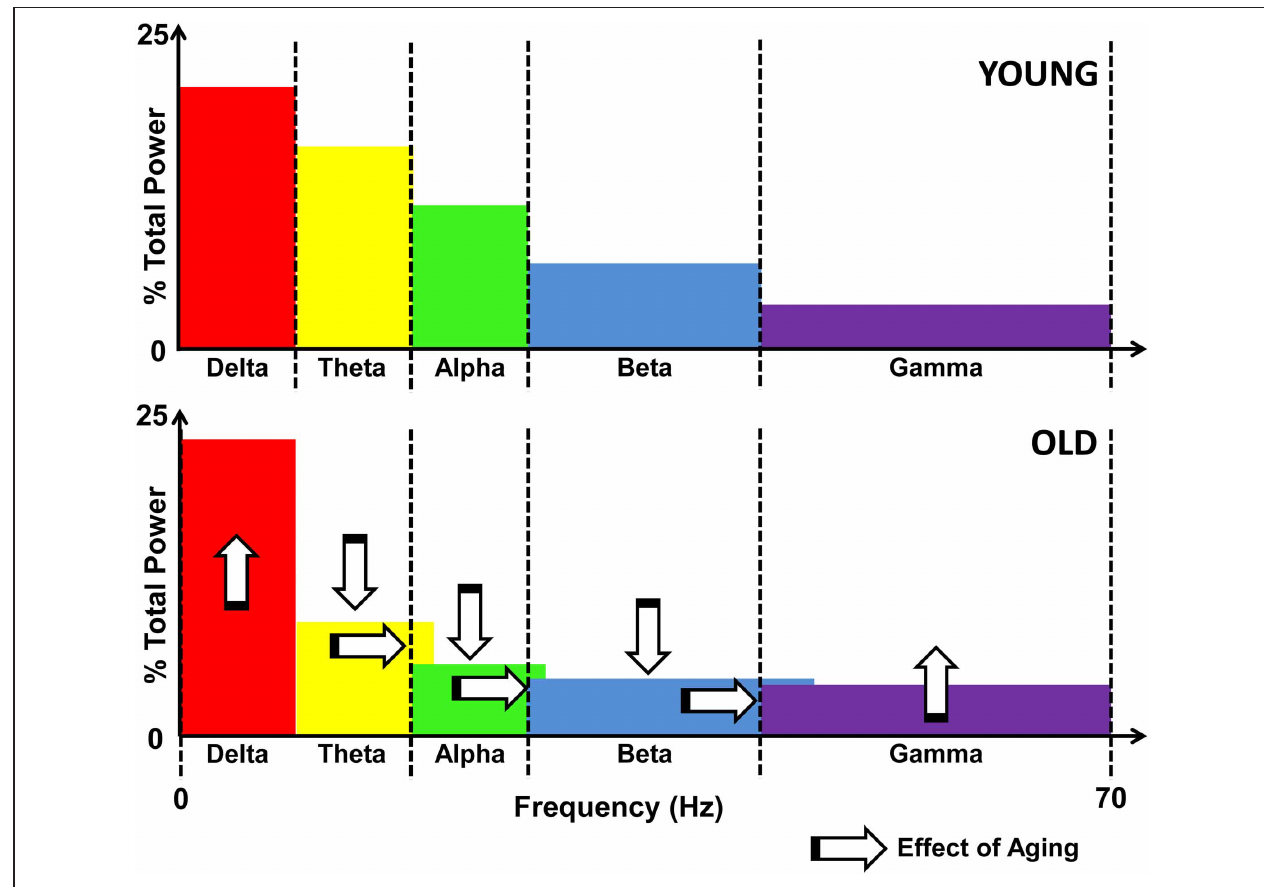
power, and decreased theta, alpha, and beta activity, as marked by vertical arrows. Also denoted is the spillover effect that results from compensatory speeding, denoted by the horizontal arrows as well as the overlapping color